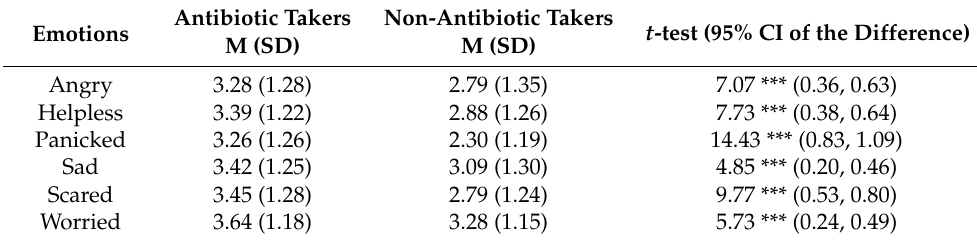
Table 4. Emotional reactions over COVID-19 pandemic by antibiotic takers and the